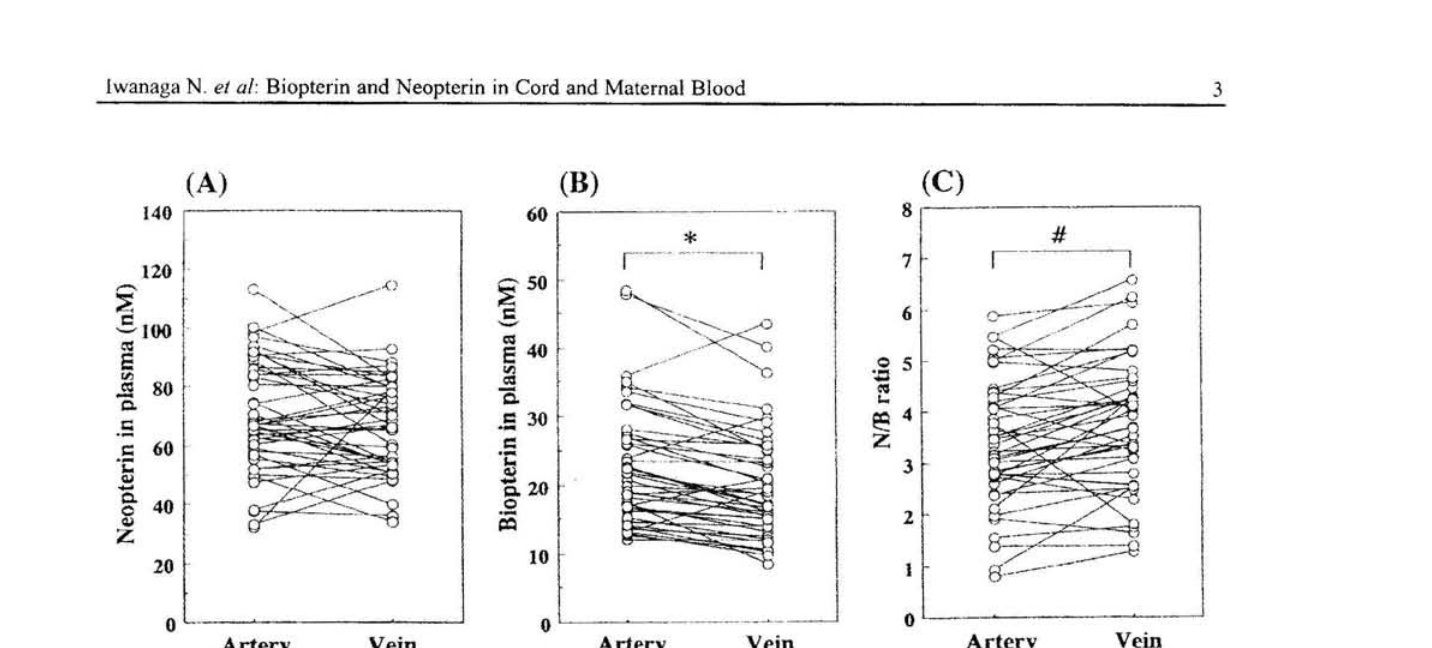
Artery Vein Figure 1 Comparisons of neopterin and biopterin concentrations between the umbilical artery and vein. Data